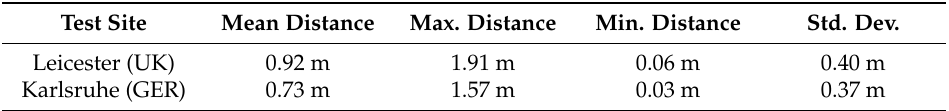
Table 2. Mean distance, maximum and minimum distance and standard deviation between building outlines and their borders in the height data (DSM) for the Leicester and Karlsruhe test